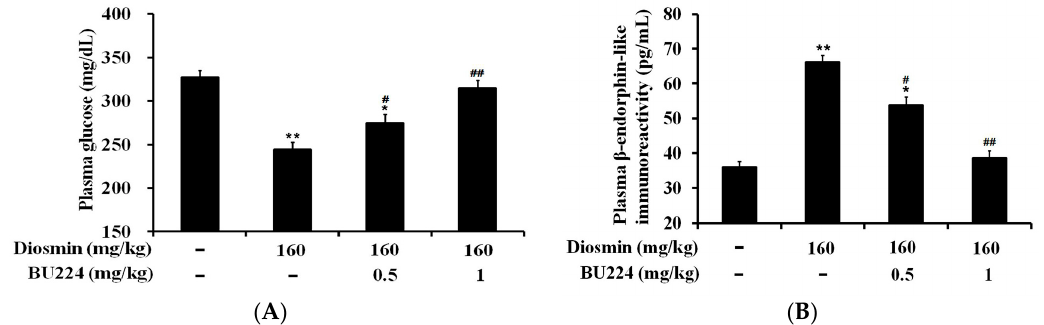
Figure 3. Effects of diosmin on plasma glucose and β -endorphin levels were inhibited by the blockade of I-2 receptors using an antagonist. ( A ) Hyperglycemia (1st column) was reduced by diosmin, shown in the 2nd column, and this effect was dose-dependently inhibited by the blockade of I-2R using the antagonist BU224 (columns 3 and 4) in diabetic rats; ( B ) Plasma β -endorphin (1st column) was increased by diosmin (2nd column), and this effect was dose-dependently inhibited by the blockade of I-2R using the antagonist BU224 (columns 3 and 4) in diabetic rats. The values are presented as mean ± SEM ( n = 8). * p < 0.05 and ** p < 0.01 compared with the indicated basal level of vehicle-treated diabetic rats in the 1st column. # p < 0.05 and ## p < 0.01 compared with the value resulting from the treatment with diosmin (2nd column) only.